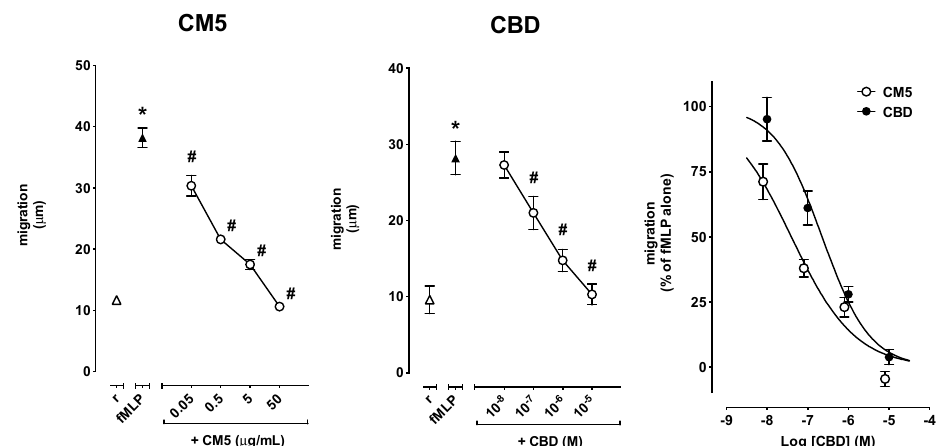
Figure 3. Effect of CM5 and CBD on fMLP-induced PMN migration shown as absolute values (left and centre panels) and as the percent of inhibition of migration of fMLP–stimulated PMN (right panel). Values are mean ± standard error of the mean (SEM) of 5–11 separate observations. * p < 0.0001 vs. resting and # p < 0.001 vs. fMLP alone.